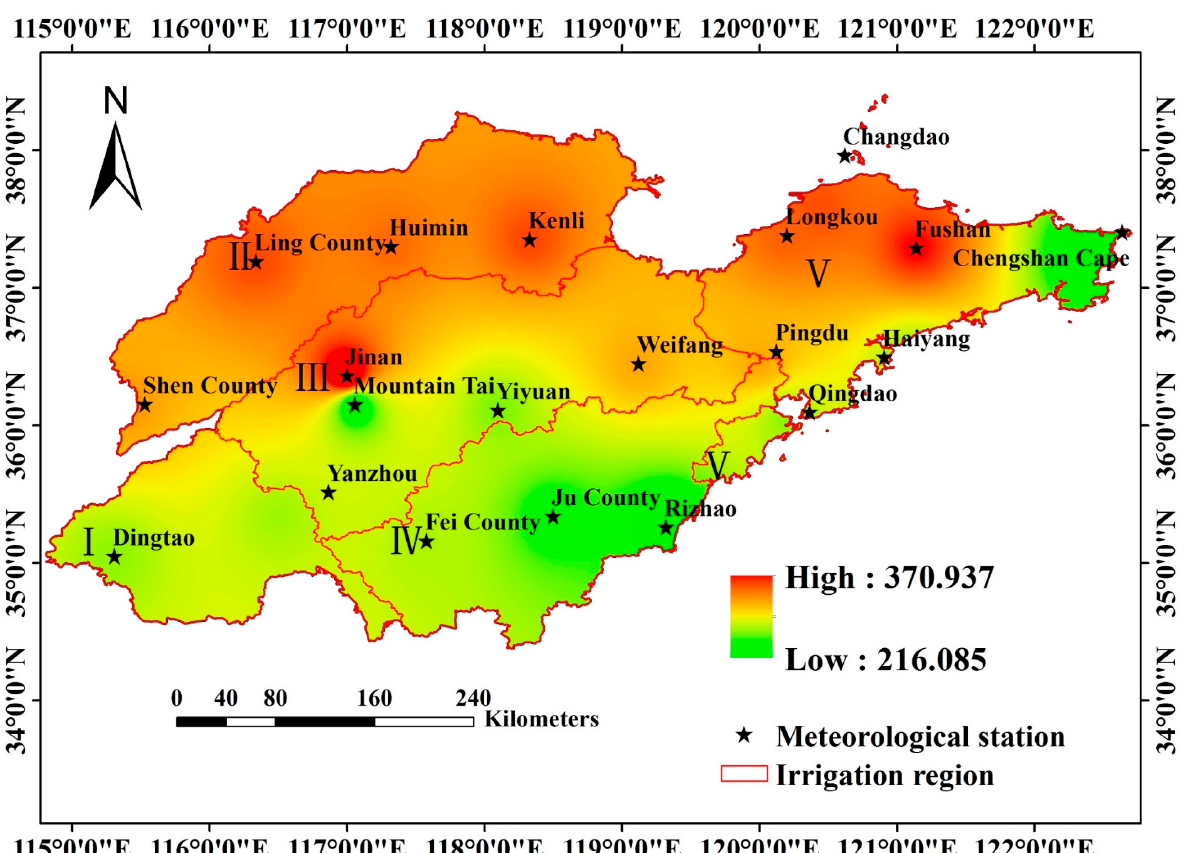
Figure 7. Spatial distribution of annual average irrigation water requirements of winter wheat.